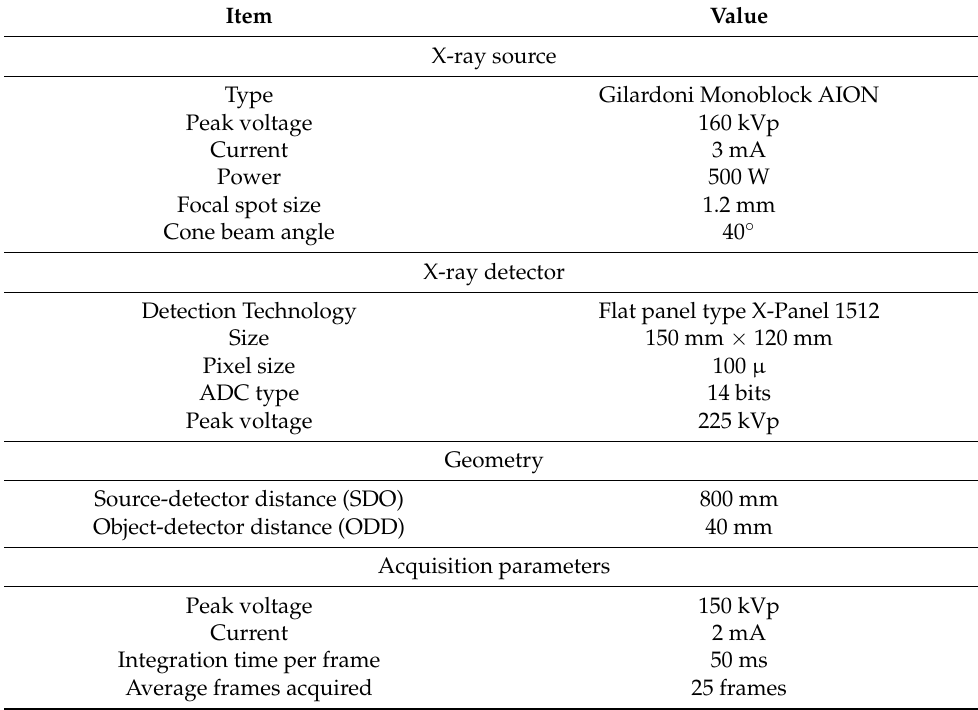
Table 5. X-ray setup description used to perform X-ray